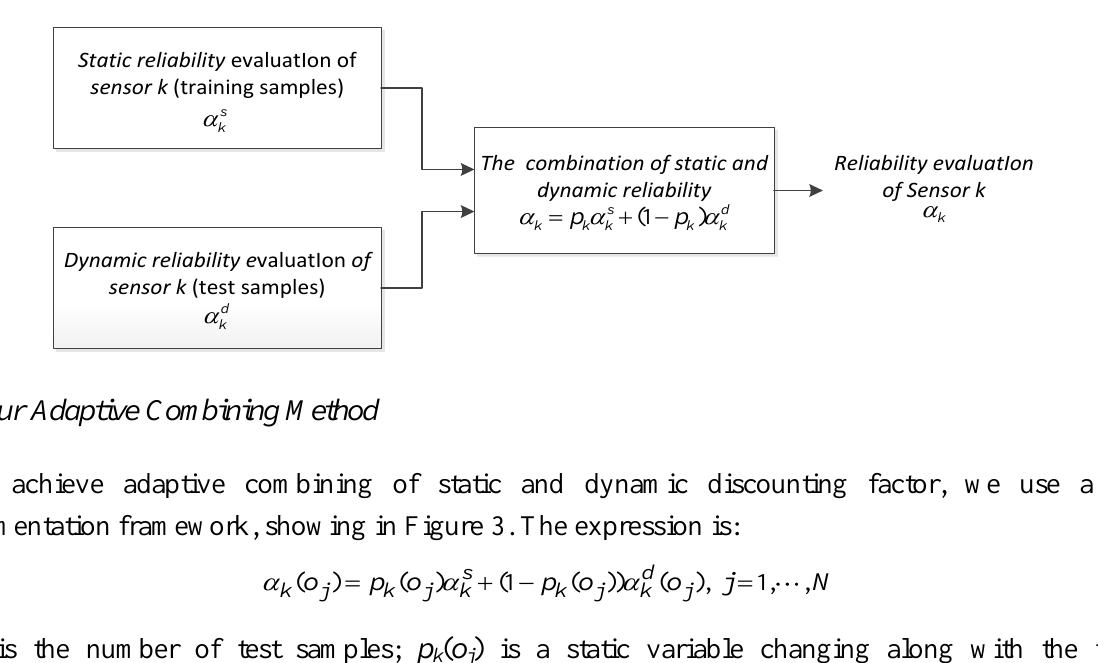
Figure 2. Implementation framework of Guo’s combining method.